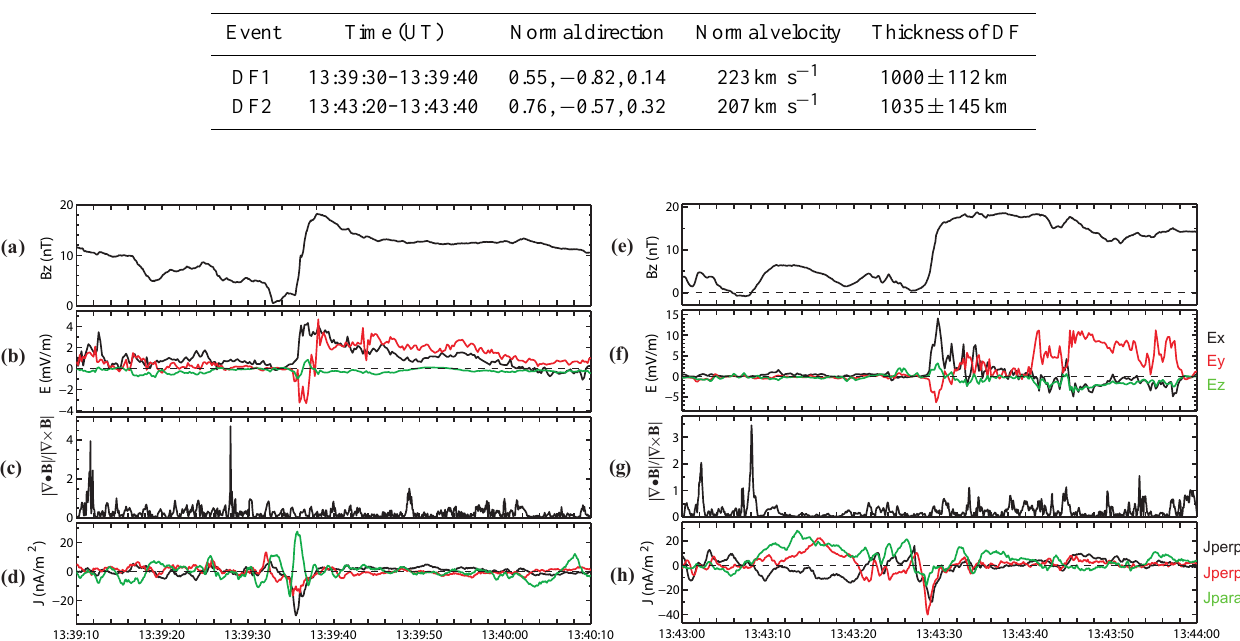
Fig. 3. Overview of electric field and electric current density around two DFs. (a) – (b) and (e) – (f) are the magnetic field component B z and electric field of Cluster-4, respectively. (c) and (g) are the values of |∇· B | / |∇× B | . (d) and (h) are electric current density in the field aligned coordinate